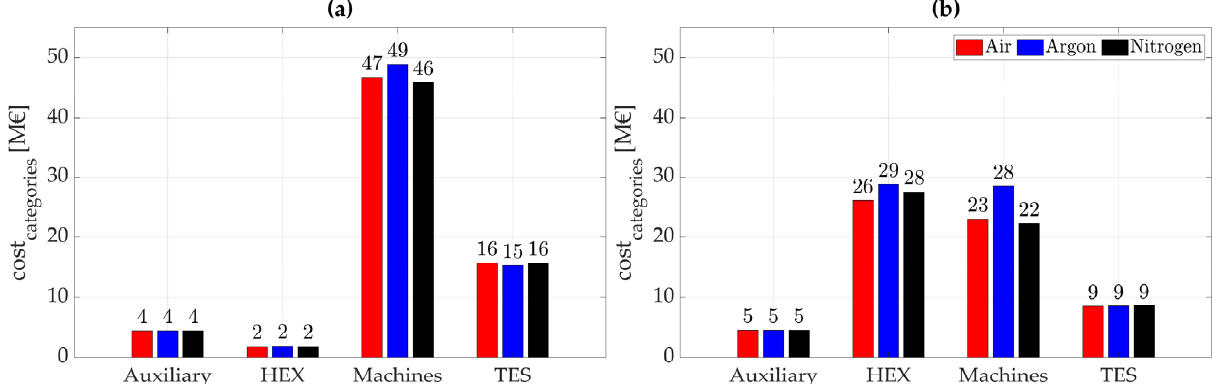
Figure 6. Cost categories for SBPTES ( a ) and LBPTES ( b ) systems for different operating fluids. Auxiliary comprises electric motors and generators; HEX accounts for heat exchangers and air coolers; Machines comprises turbines and compressors; TES materials represents hot and cold reservoir storage media; finally, TES tank comprises hot and cold reservoir containers. The results are related to a case with W net , ch = 50 MW, τ ch = 8 h and R ut = 0.8. For LBPTES, the results refer to a configuration with η rt ≈ 0.58.